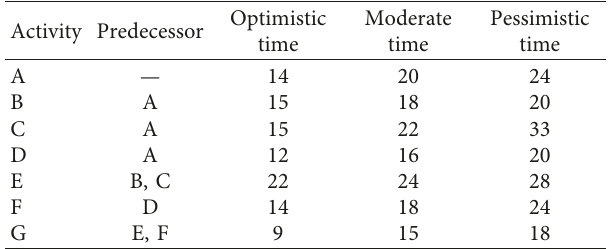
Table 3: Activity duration and